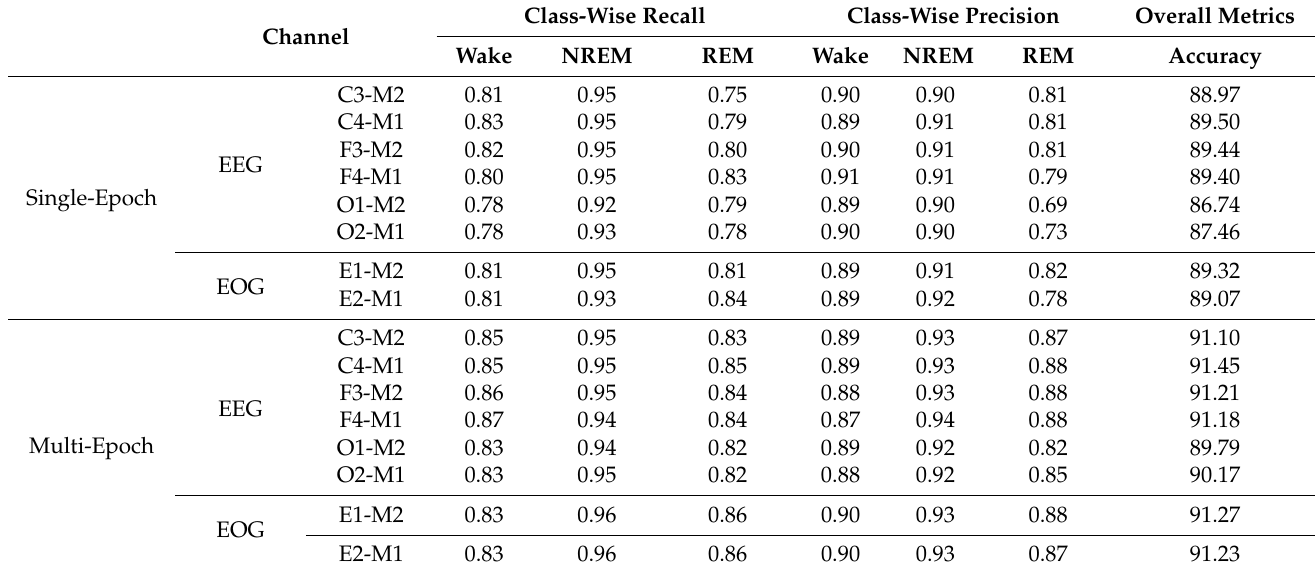
Table 6. Accuracy performance of a single channel-based deep learning model according to the channel types (EEG/EOG) and positions.